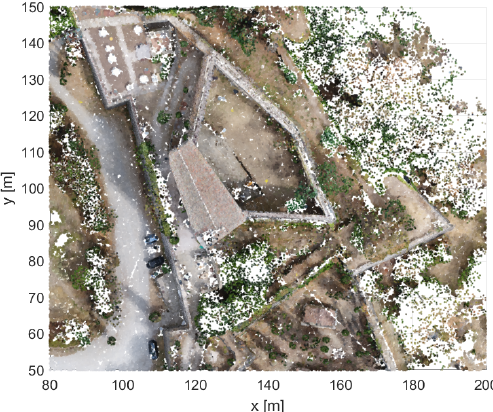
Figure 7. Reduced size point